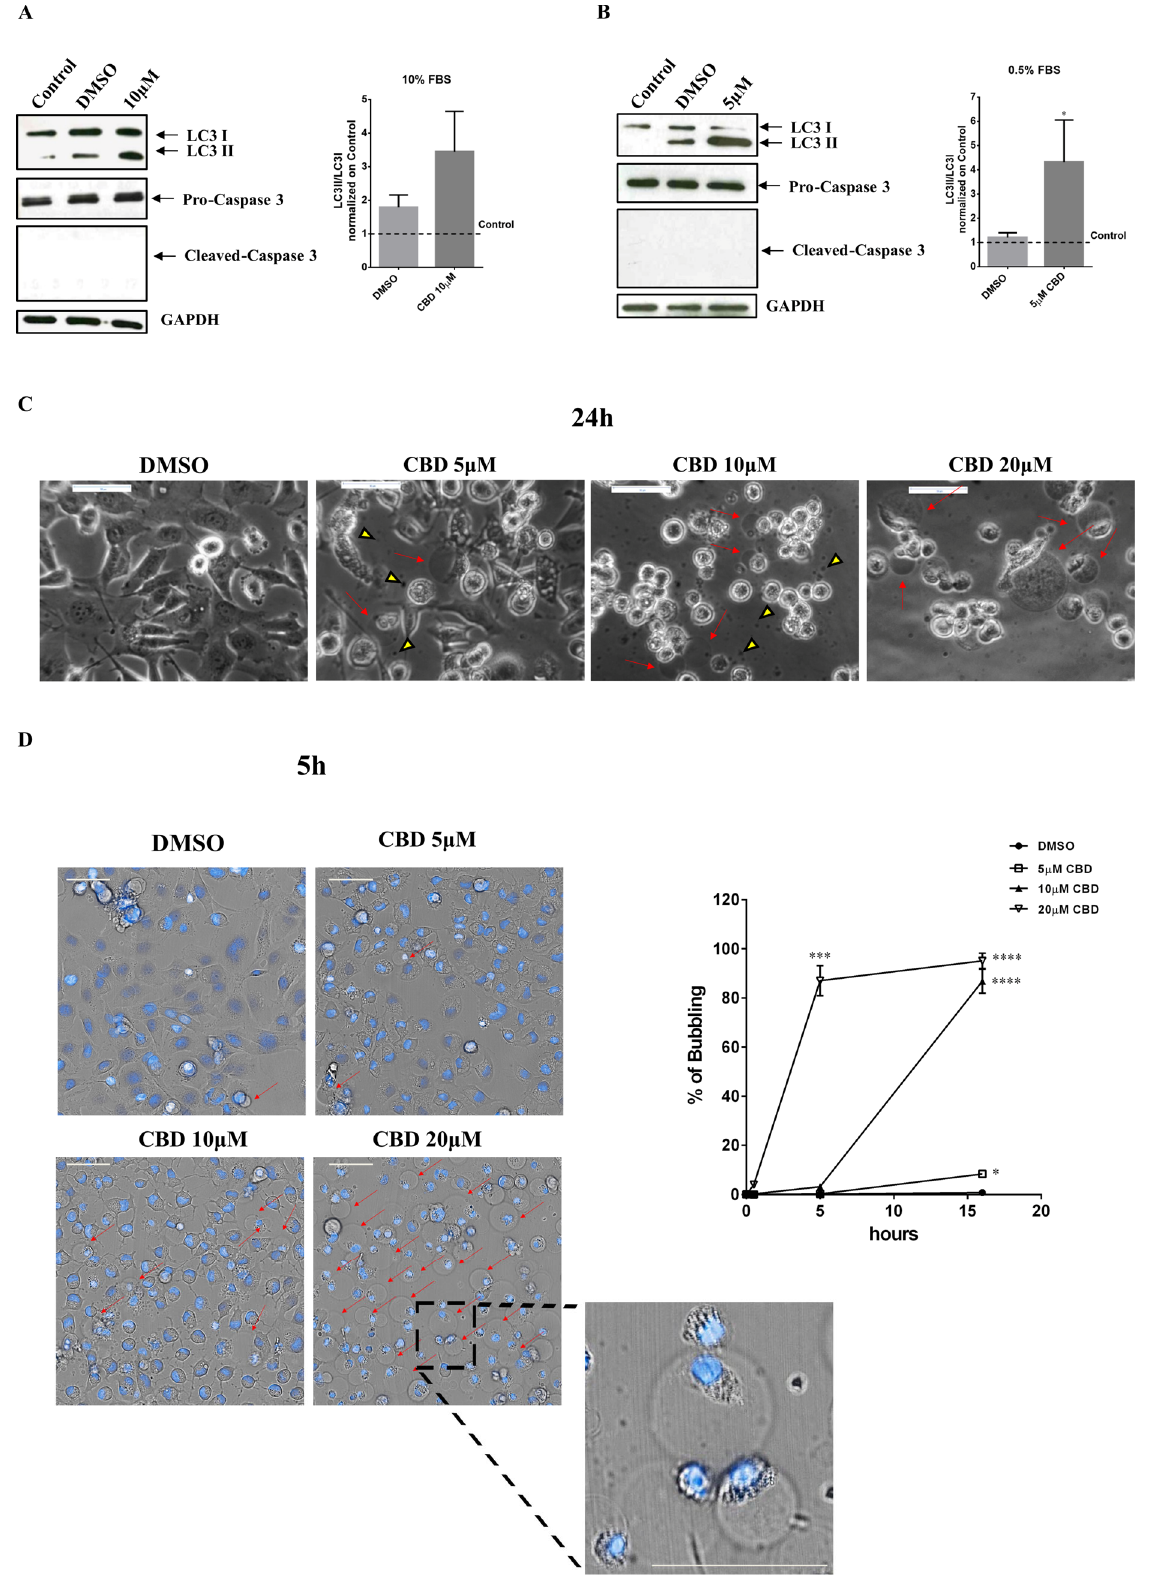
Figure 4. CBD induces autophagy and bubbling cell death in low serum conditions. MDA ‐ MB ‐ 231 cells were seeded, and the day after, the medium was replaced either: ( A ) with DMEM 10% FBS, containing or not 10 μ M CBD; or ( B ) with DMEM 0.5% FBS, containing or not 5 μ M CBD (DMSO is referred to as control). Cell lysates were separated on SDS ‐ PAGE and blotted to nitrocellulose mem ‐ brane; blots were probed with anti ‐ LC3, anti ‐ caspase3 or anti ‐ GAPDH antibodies. GAPDH was